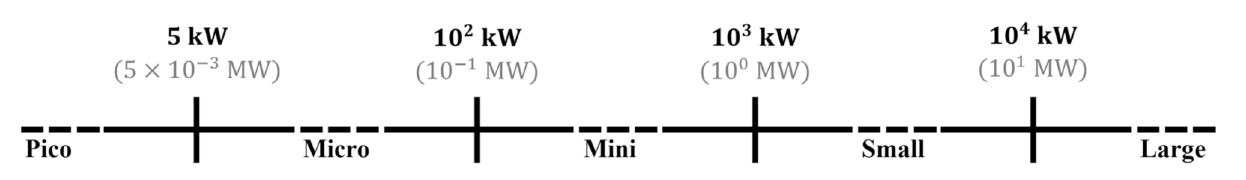
Figure 1. Classification of hydropower plants based on the installation